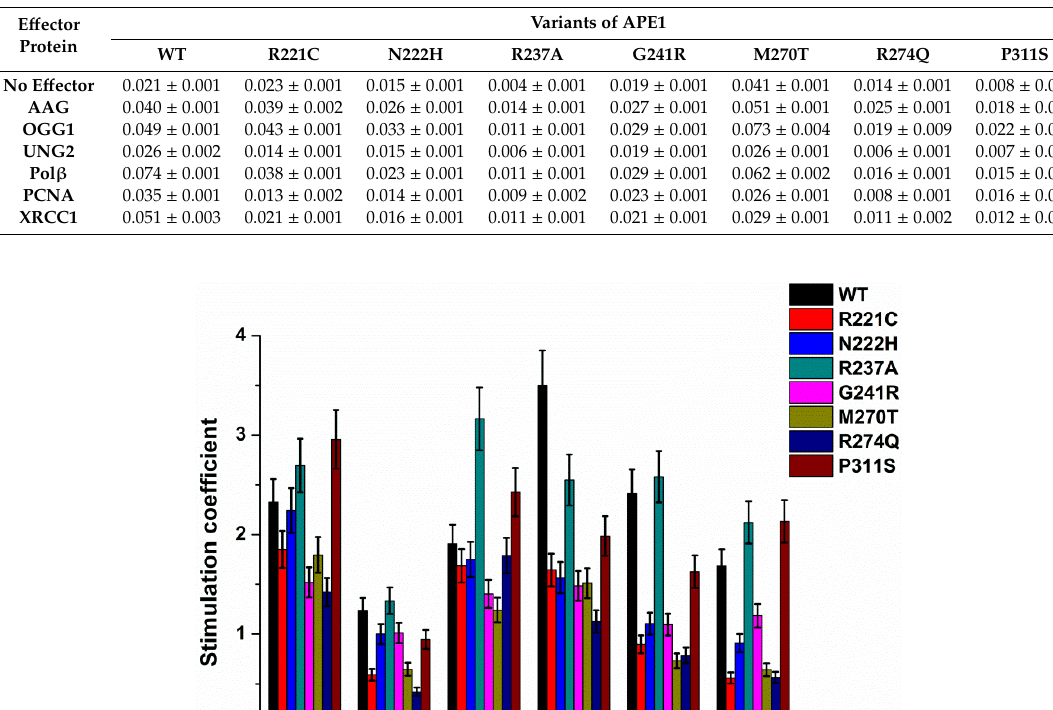
Table 2. Observed rate constants ( k obs , s − 1 ) of F site cleavage by WT APE1 or its SNP variants in the presence or absence of an e ff ector protein.